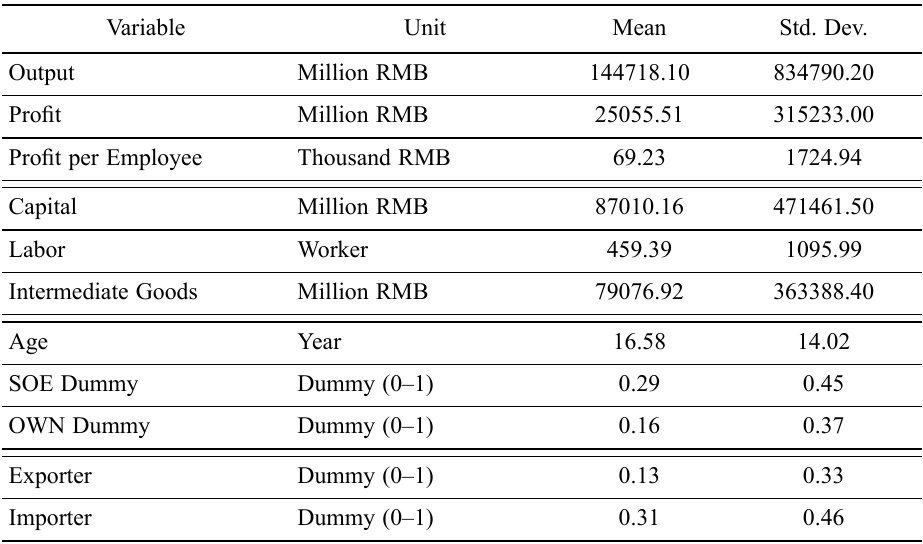
Table 1. Summary